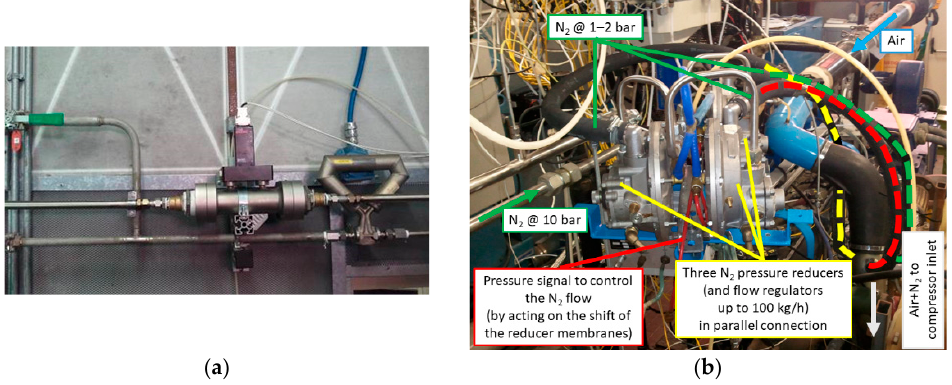
Figure 3. Lines and mass flow meters for equivalent syngas fuelling: ( a ) combustible fraction (CH 4 and H 2 ); ( b ) inert fraction (N 2 ). Nitrogen is delivered by tanks at 10